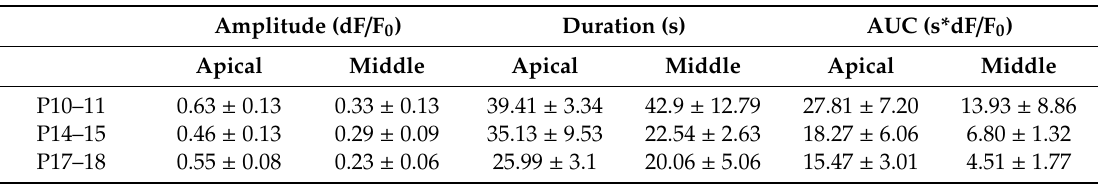
Table 6. Magnitude and kinetic characteristic of UTP (100 µ M) induced Ca 2 + transients in the soma of Deiters’ cells (mean ±